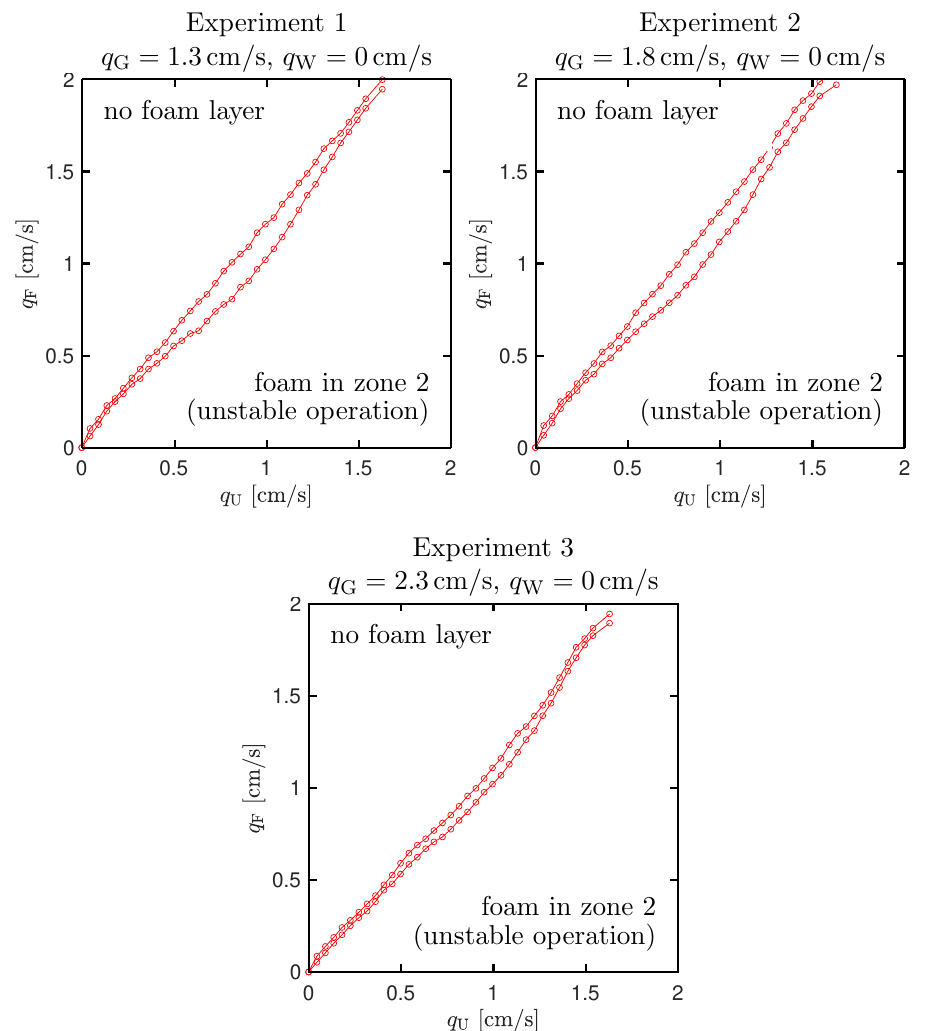
Figure 3. Experiments 1–3 (no wash water added): stability regions enclosed between two curves formed by points in the ( q U , q F ) plane.